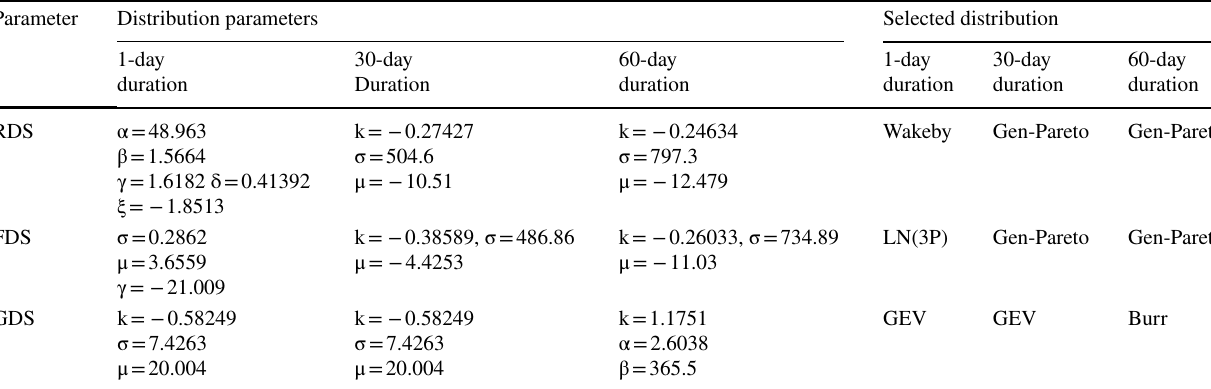
Table 2 Results of fitting the marginal distribution on the studied signatures Parameter Distribution parameters Selected